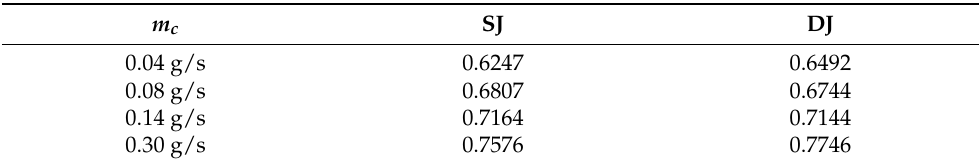
Table 5. The area ‐ averaged overall cooling effectiveness. m c